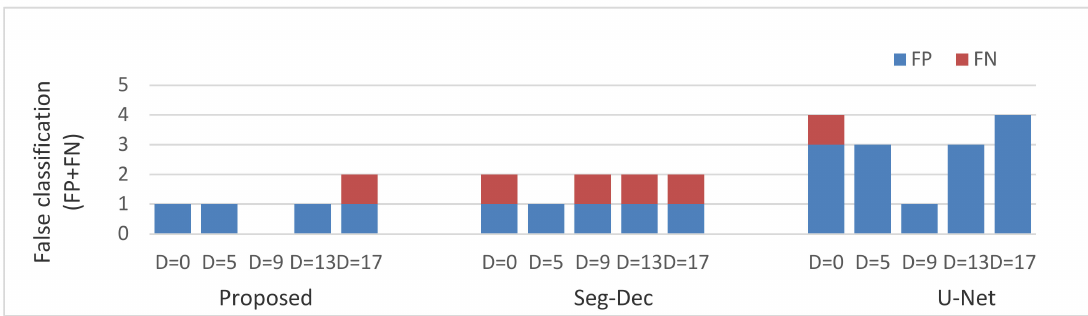
Figure 10. FP and FN comparisons with di ff erent dilate rate.